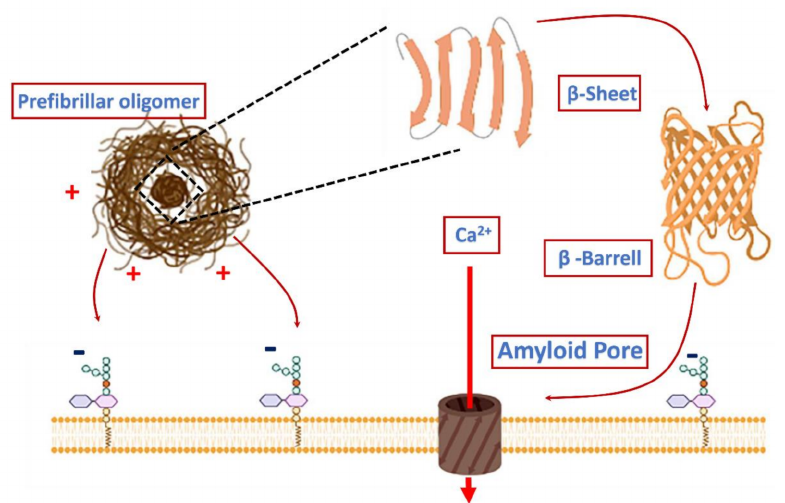
Figure 4. The possible pore formation mechanism by an amyloid PFO. According to the most recent data collected in the literature, the typical amyloid PFO may have the shape of a sphere with a stiff hydrophobic core, partially structured in a β -sheet. The surface of the sphere exposes both polar and hydrophobic protein sequences. The first, exposed to the solvent and likely charged, are responsible for interaction with charged parts of the membranes, such as the GM1 forming the “lipid-rafts”. After the contact, the partially ordered PFO hydrophobic core, in order to minimize the hydrophobic mismatch with the membrane backbone, forms a permeable amyloid pore assuming a β -barrel conformation favored by the ordered structure of the